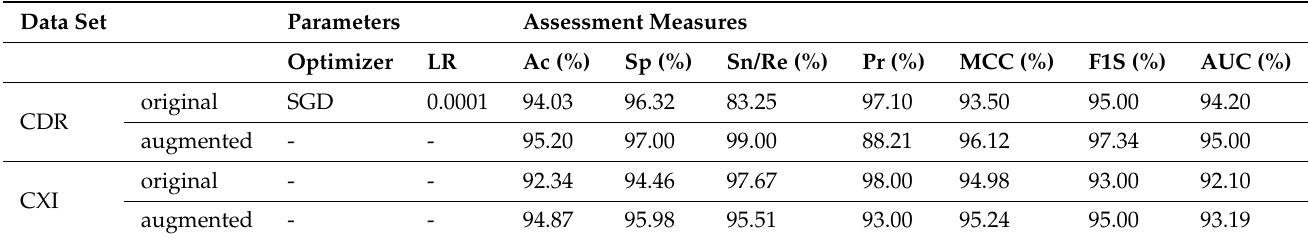
Table 4. ResNet-50 model performance evaluation on original and augmented CRD and CXI data sets. Data